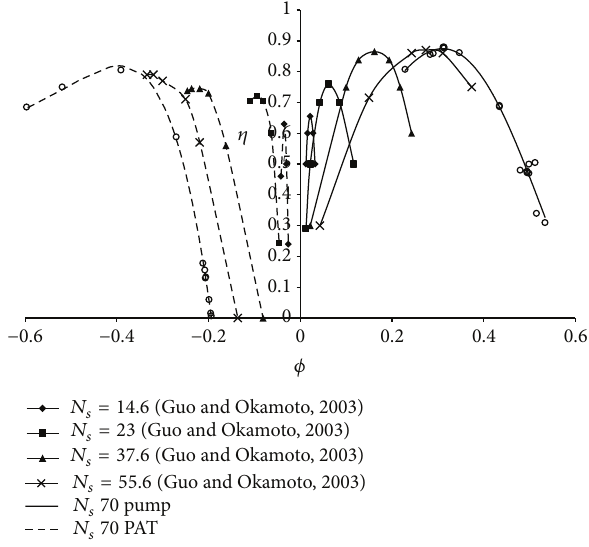
Figure 4: Dimensionless efficiency curves of PAT in pump and turbine modes—comparison to Derakshan et